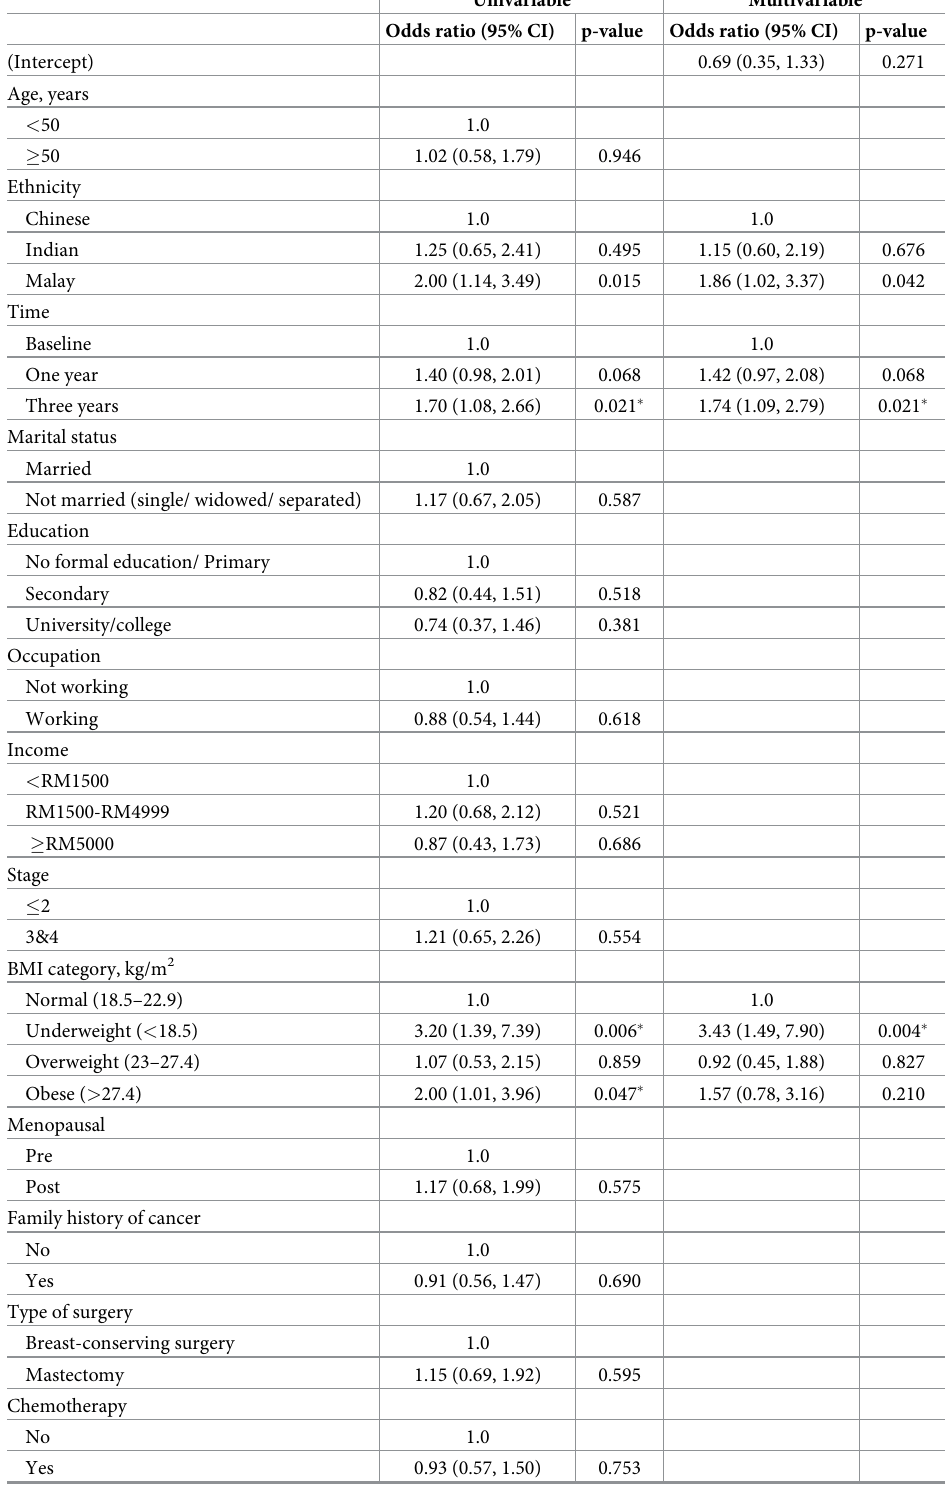
Table 5. Factors associated with inactivity among breast cancer